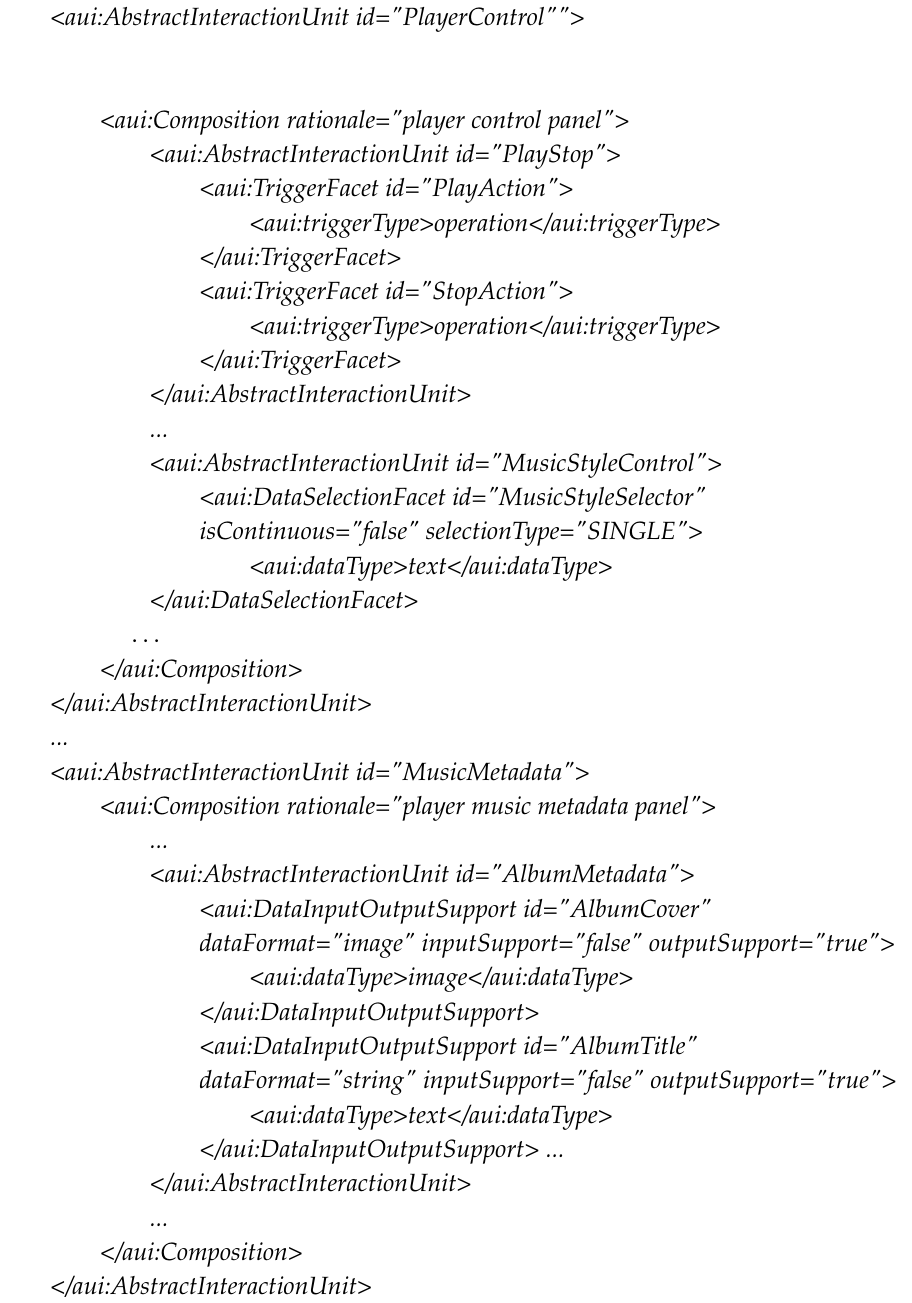
Algorithm 1. Reduced XML code describing the Abstract UI model for the EMP.